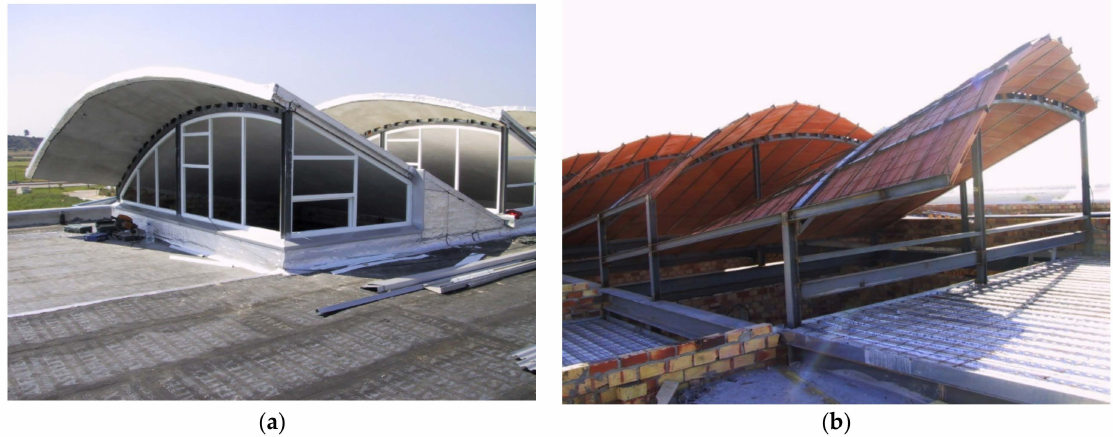
Figure 6. Views of the new skylights. ( a ) Final view; ( b ) under construction. Regarding the materials, the conoidal surfaces were designed with the thermal mass on the inside because, due to their geometry and orientation, a high solar radiation incidence was expected. After studying various material combinations, we decided to use the following construction system (from inside to outside): 40 mm perforated brick with plaster inside 10 mm; 150 mm concrete; 40 mm extruded polystyrene (XPS); and, finally, an external self-protected waterproofing